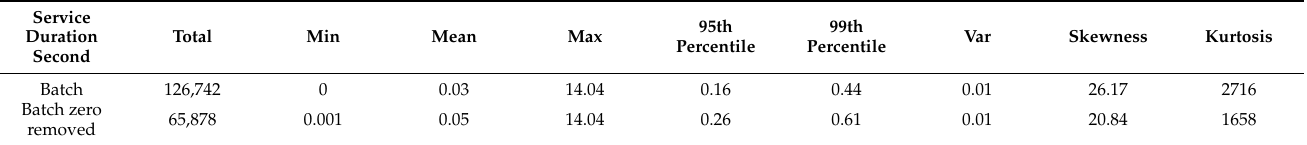
Table 9. Service times, batch by category statistics.